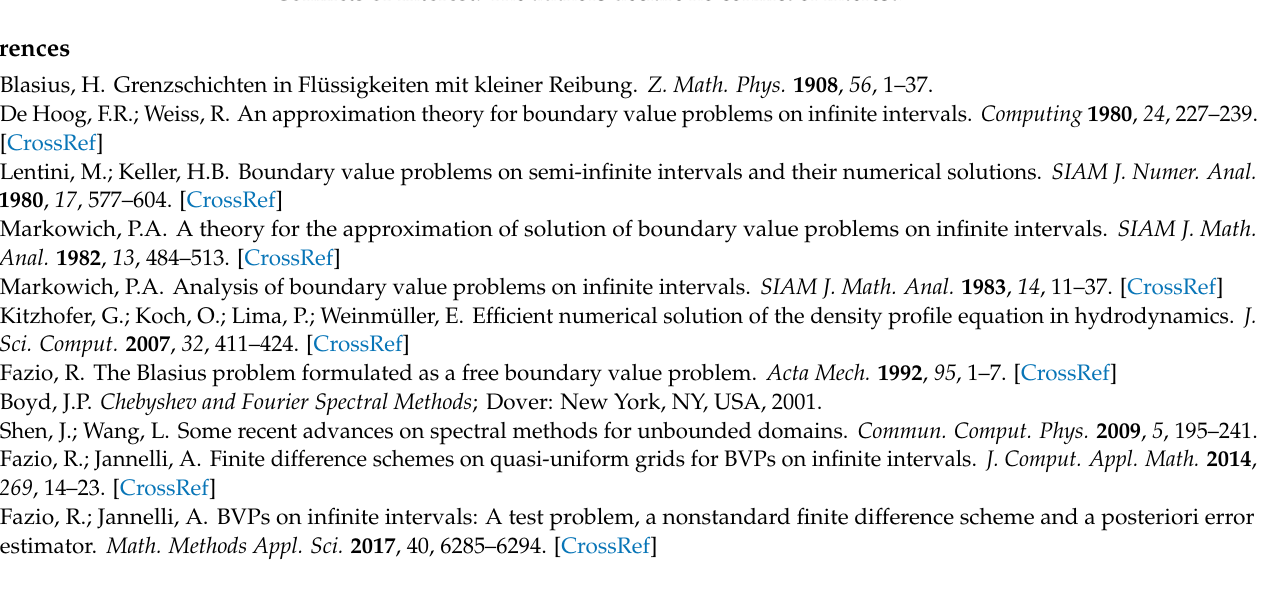
Table 4. Extrapolated values at origin x = 0 for